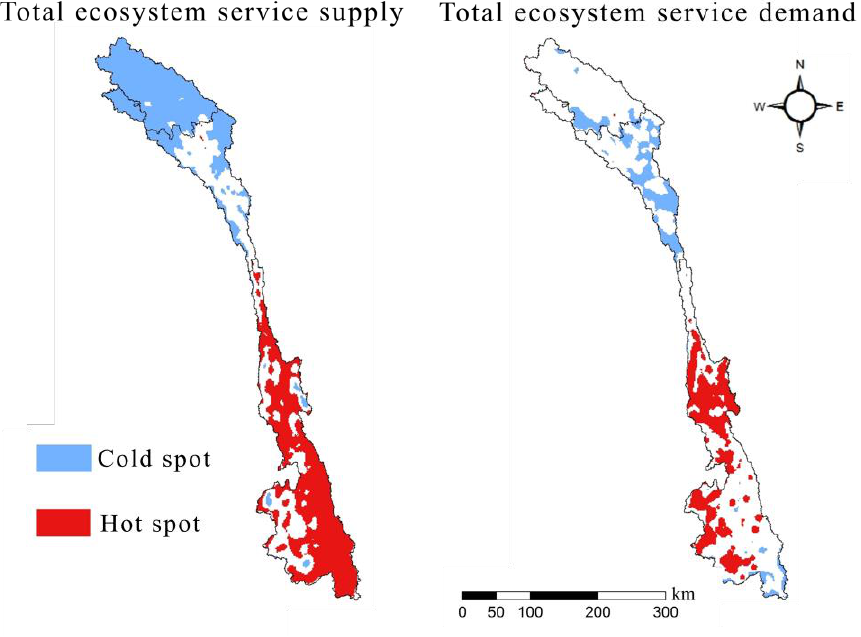
Figure 5. Local spatial patterns of ES supply and demand.